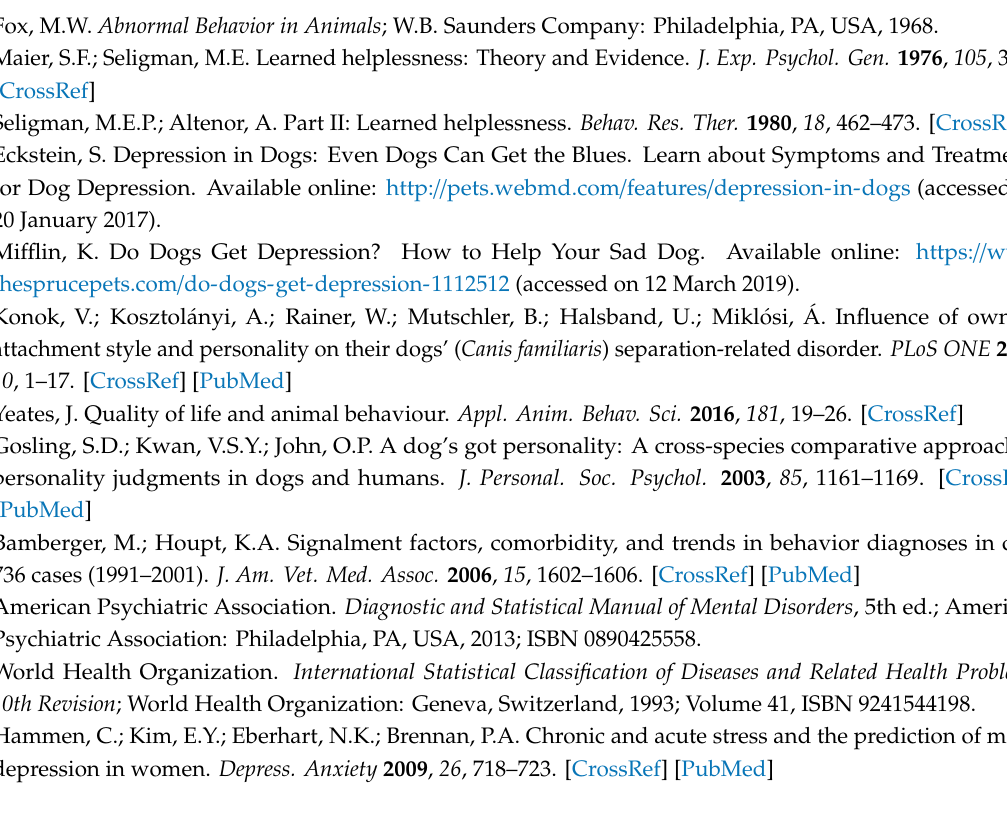
supplementary text describing pilot study. Table S1: Median percentage of scans, first and third quartiles and minimum and maximum values for behaviour in the pilot study based upon scans using 1.5 min. Table S2: PCA component loading table for QBA scores overlaid with Kong TM test variables and home-pen “awake but motionless” behaviour. Table S3: Kendall’s tau-b correlations comparing all potential confounding variables. Table S4: Statistics from multi-variate general linear regressions comparing variables from the Kong TM test to time spent awake but motionless in the home kennel (logarithmically transformed) alongside potential confounding